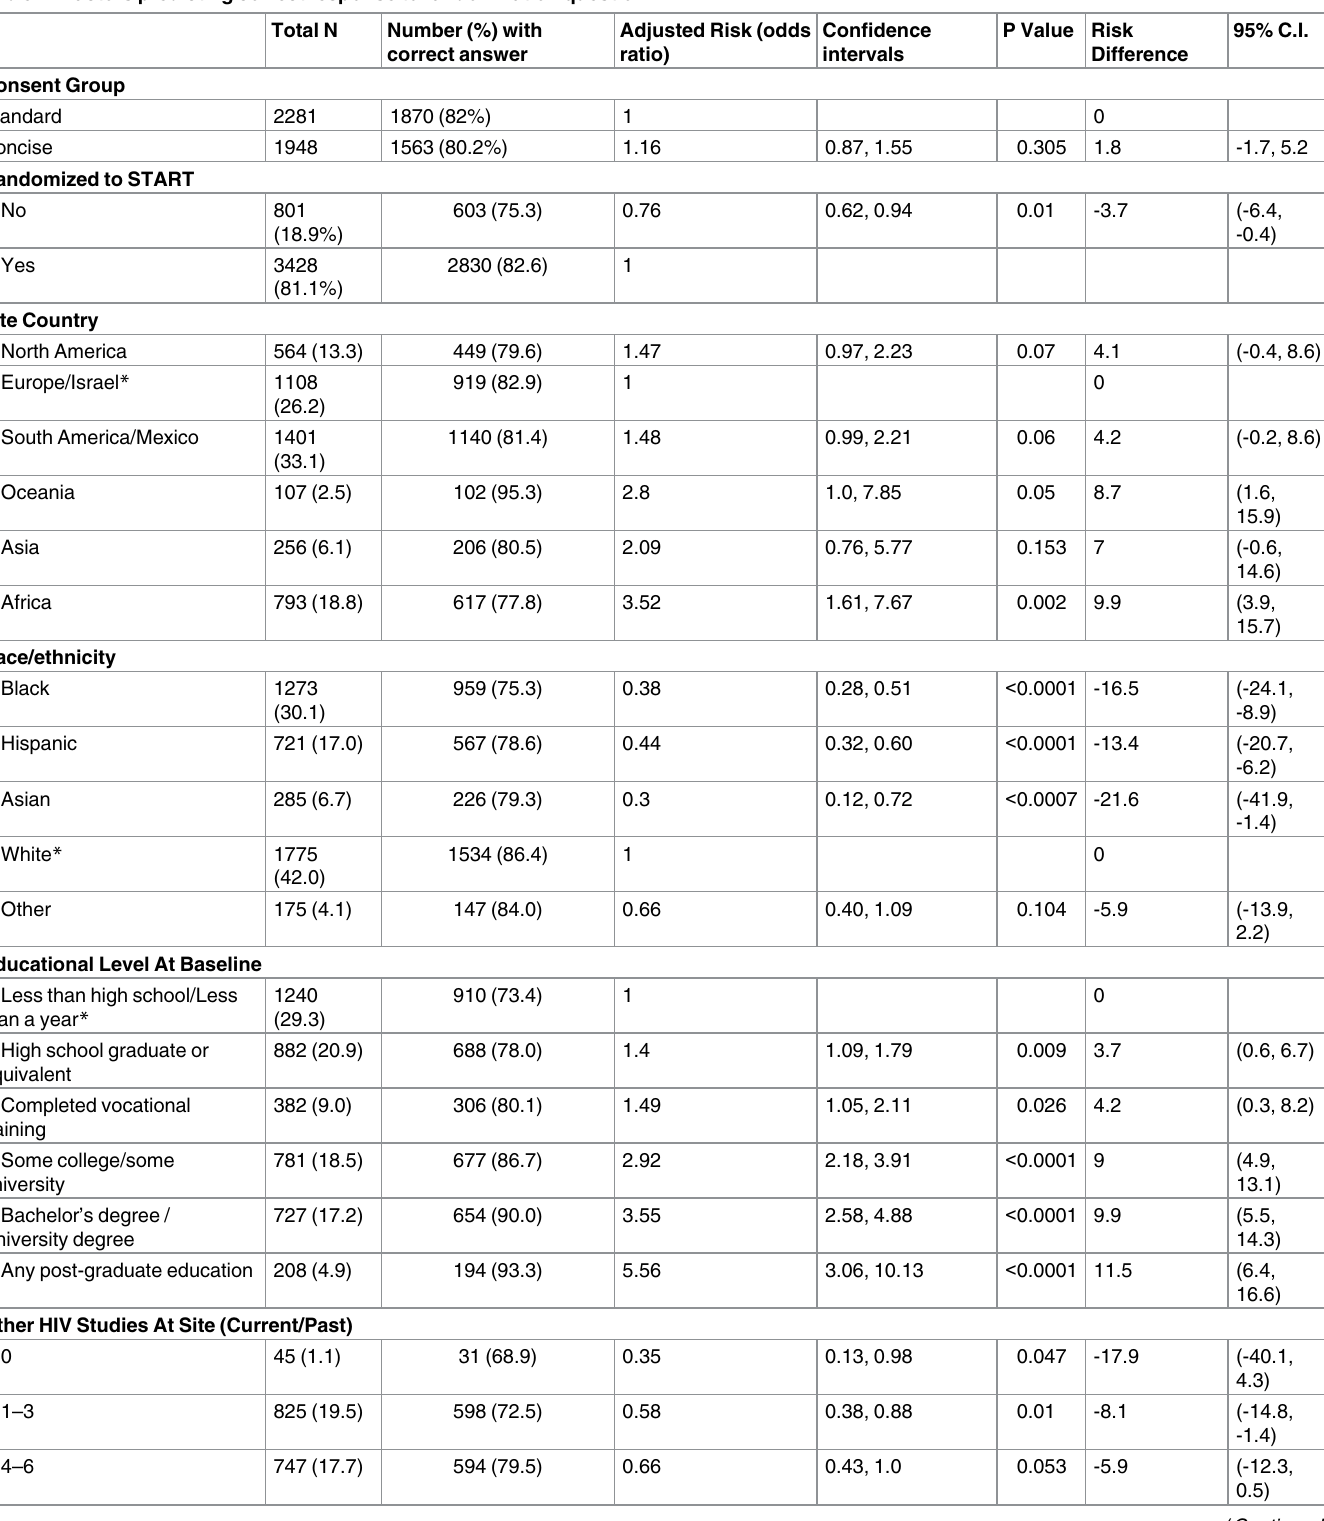
Table 4. Factors predicting correctresponse to randomization question.